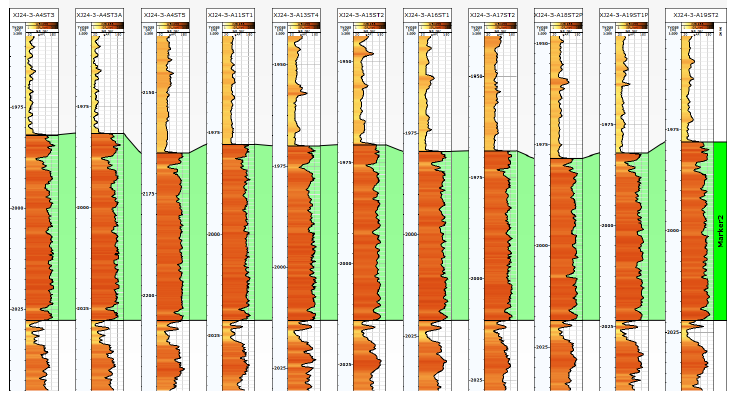
Fig. 3 Profile of well connection of marker bed in the study area.